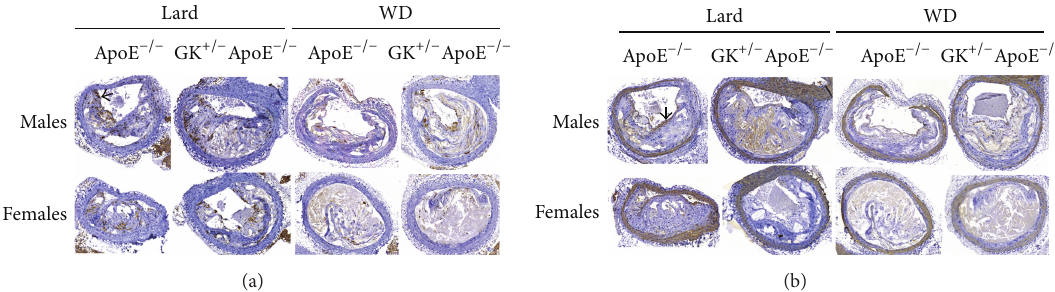
Figure 6: The atherosclerotic lesions of the brachiocephalic artery in both genotypes have become advanced and complicated after Lard and WD for 14 and 23 weeks, respectively. Large areas of the lesions consist of necrotic core and cholesterol clefts. (a) Only a few scattered macrophages(brownindicatedbyarrowonthefigure)aredetectedbythemacrophageantibody.(b)Smoothmusclecells(brown)aredetected in the vessel wall by the alpha-actin antibody. A thin cap is sometimes seen in the lesions, indicated by arrow on the figure. Images in Figures 6(a) and 6(b) are consecutive sections from the same animal.